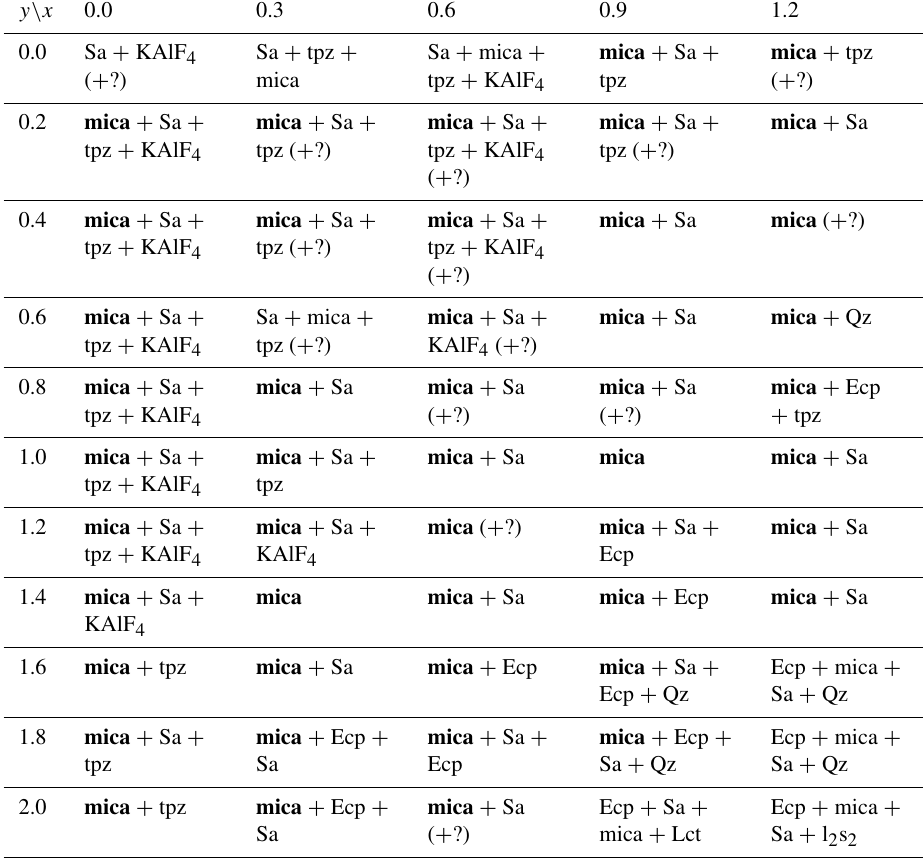
Table 3. List of phases as determined by X-ray diffraction for the nominal compositions of the reaction mixtures along the trilithionite– muscovite join. The various phases are listed in order of relative quantity. Products with mica as major phase are printed in bold letters. Symbols – Qz: SiO 2 (quartz), Ecp: eucryptite, Sa: sanidine, Lct: leucite, l 2 s 2 : Li 2 Si 2 O 5 lithium disilicate, tpz: topaz. Some impurity phases which could not be identified are marked with